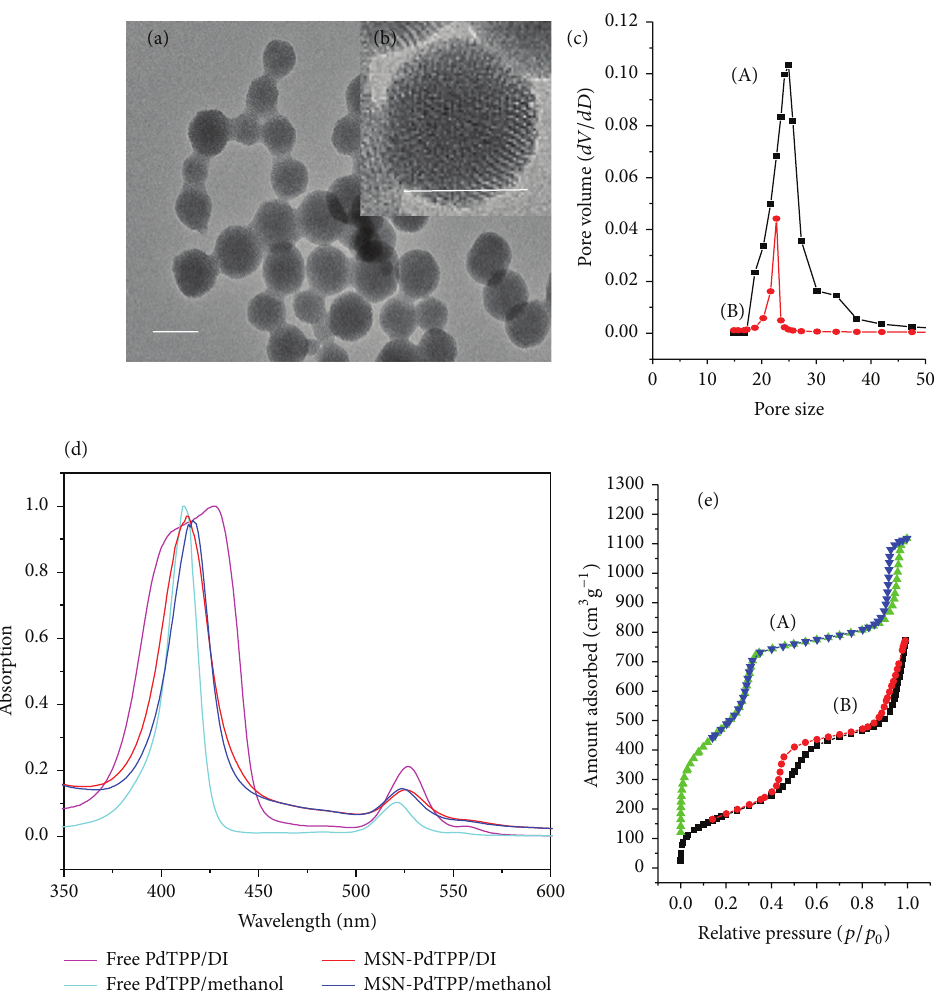
Figure 1: Nanoparticle characterization. (a) TEM images of MSN-PdTPP nanoparticles (scale bar: 100nm). (b) Well-ordered porous structure of MSN-PdTPP (scale bar: 100nm). (c) Pore size distribution of (A) MSN and (B) MSN-PdTPP derived from desorption isotherm measurements and BJH method. (d) UV-visible absorption spectra of PdTPP and MSN-PdTPP in DI water and methanol. (e)